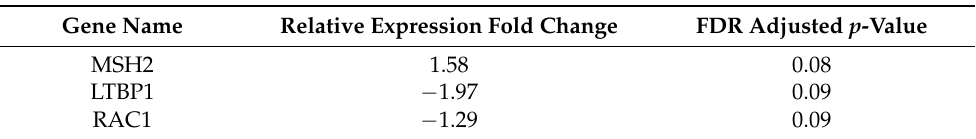
Table 4. Differentially expressed genes between postmolar choriocarcinoma and post-term delivery choriocarcinoma samples (FDR <